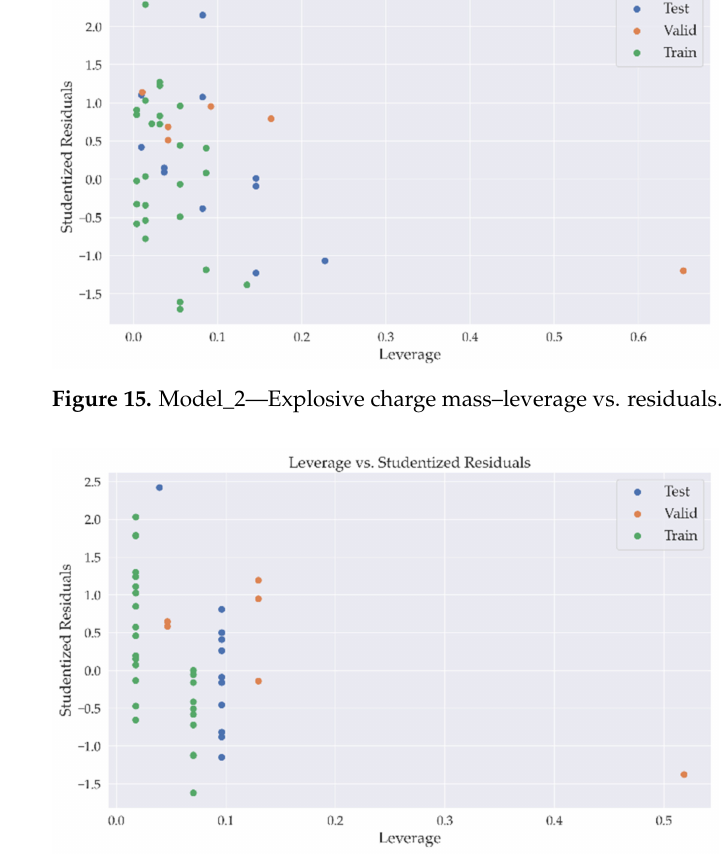
Figure 16. Model_1—Stem length–leverage vs. residuals.